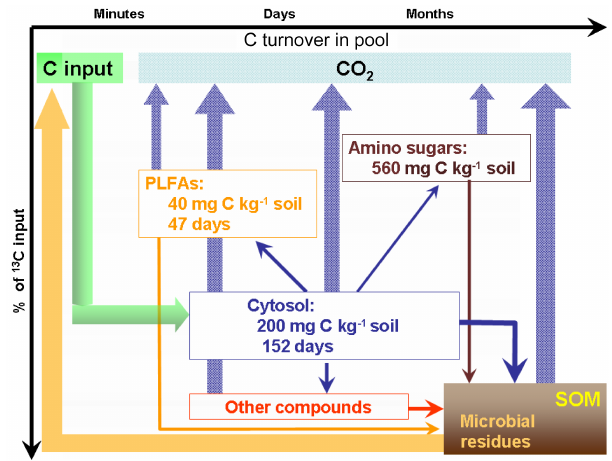
Figure 5. Dynamic relationships between microbial glucose utiliza- tion and C turnover times in cytosol, cell membrane and cell wall